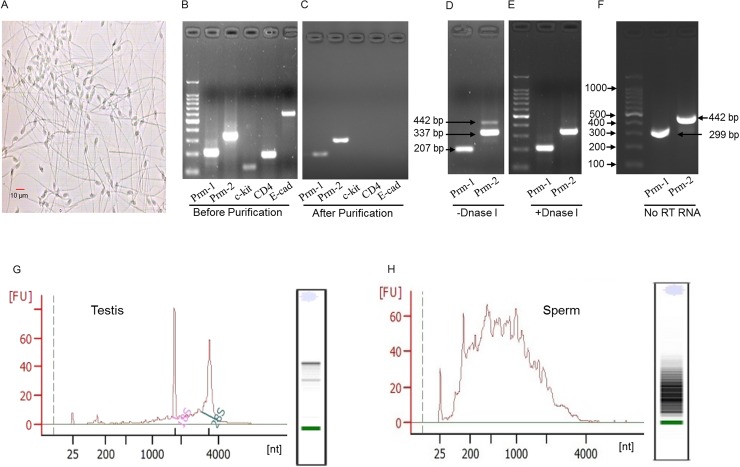
Quality control of sperm RNA.Confirmation of sperm purity and electrophoretic size distribution of extracted total sperm RNA. (A) Morphology of collected sperm under phase contrast microscopy. (B) Biomarkers of leukocytes (CD4), testicular germ cells (c-kit) and epithelial cells (E-cadherin) could be amplified easily from the RNA extracted from unpurified sperm sample. (C) After sperm was purified, non-sperm cell markers (CD4, c-kit, E-cadherin) were unable to be amplified from the RNA extracted from our purified sperm sample, while positive markers of sperm (Prm1 and Prm2) were easily detected. (D, E) The 442 bp PCR product of Prm2 indicated DNA contamination (D), which disappeared after DNase I digestion (E). (F) The DNA PCR product of Prm1 and Prm2 could be amplified from no reverse transcription (RT) sperm RNA. (G, H) Electrophoretic size distribution of RNAs in mouse testis (G) and mature sperm (H) analyzed by Agilent Bioanalyzer.